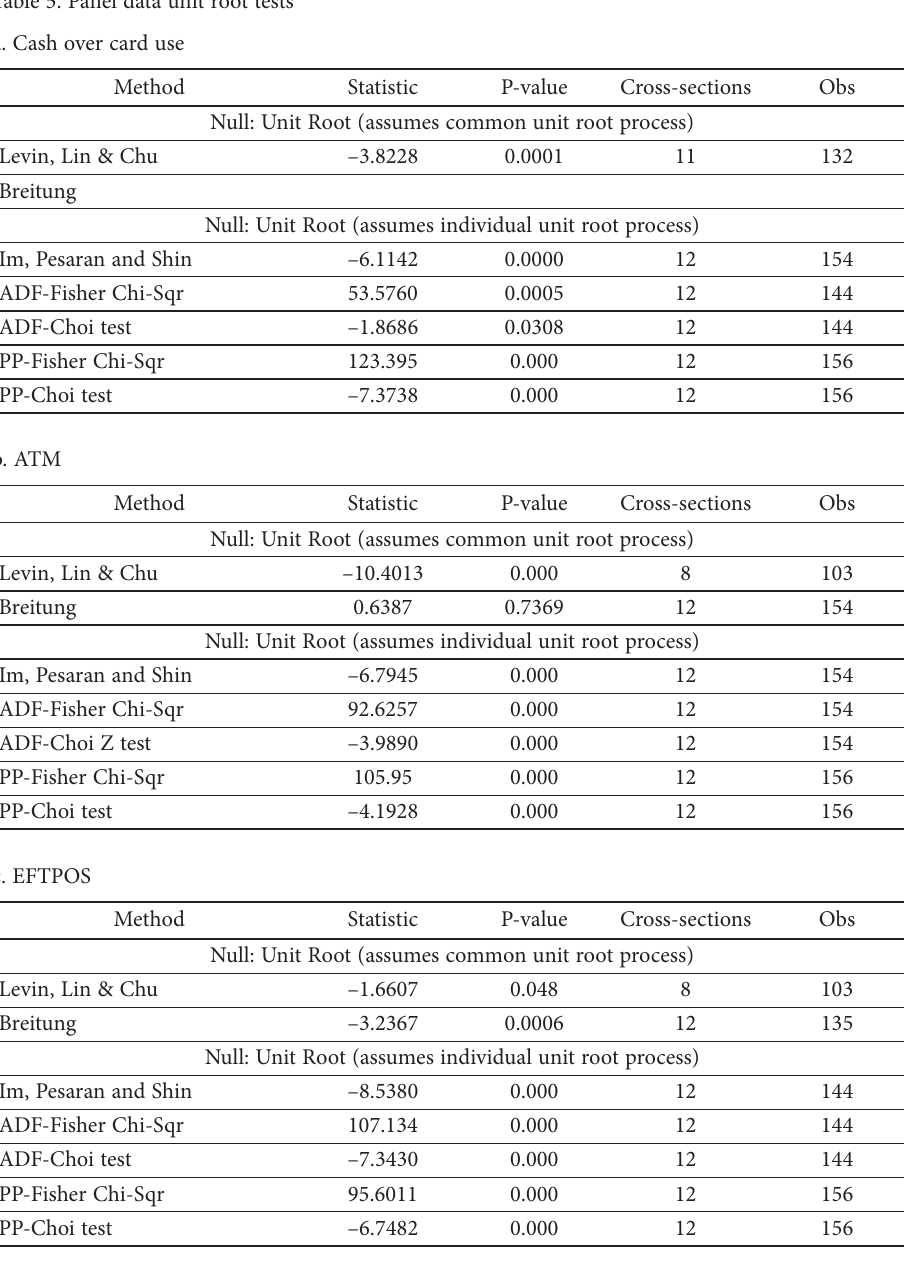
Table 5. Panel data unit root